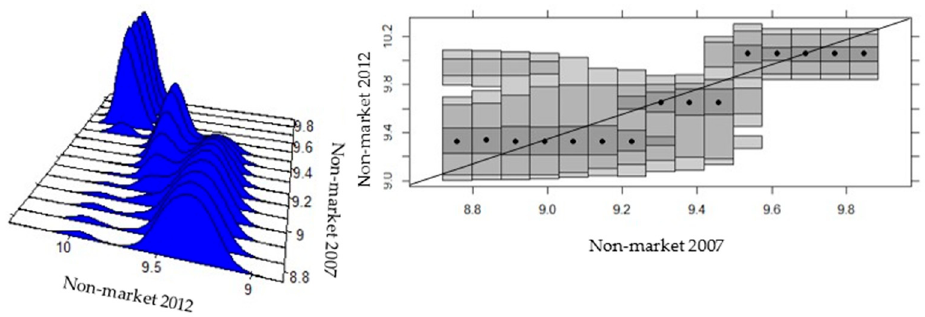
Figure 13. Intra-distribution dynamics of provincial productivity in the non-market service subsector, 2007–2012. Source: Own elaboration based on the Regional Accounts of the BCE [46]; ENEMDU surveys from the INEC [47] (several years) and stacked conditional density plot (SCD) in R.